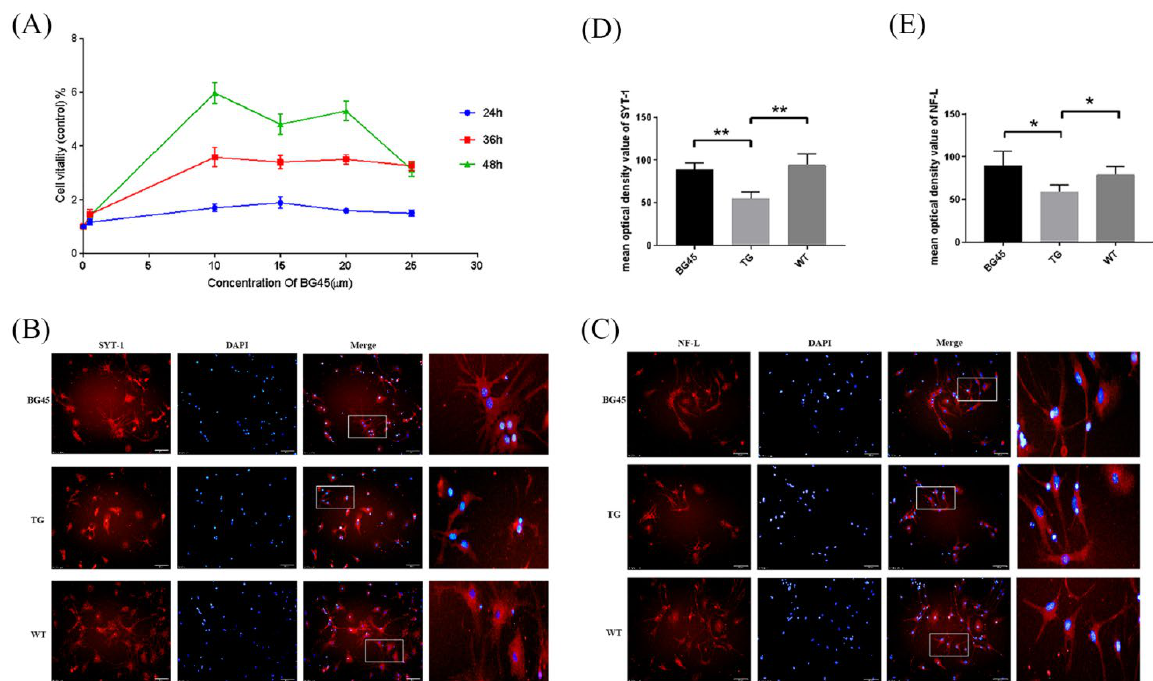
Figure 2. BG45 increased cell viability and the expression of SYT-1 and NF-L. ( A ) The viability of cells treated with BG45 (0.5, 10, 15, and 25 µ M) for 24, 36, and 48 h. ( B ) Immunofluorescence staining analysis of SYT-1 (red) in primary neurons treated with BG45 (10 µ M) for 48 h. ( C ) Immunofluorescence staining analysis of NF-L (red) in primary neurons treated with BG45 (10 µ M) for 48 h. ( D ) Quantitative SYT-1 analysis. ( E ) Quantitative NF-L analysis. The values are presented as the mean ± SD from three independent experiments. * p < 0.05 and ** p < 0.01. Scale bar = 50 μm. Immunofluorescence staining showed that compared with the WT group, the SYT-1 and NF-L protein levels were significantly decreased in the TG group ( p < 0.01, p < 0.05). Compared with the TG group, the SYT-1 and NF-L protein levels were significantly in- creased in the BG45 group ( p < 0.01, p < 0.05; Figure 2B–E). 2.3. BG45 Improved Spatial Memory and Learning Ability in APP/PS1 Mice In this study, the Morris water maze test was used to evaluate spatial memory and learning ability of mice. In the acquisition trial, the learning curve showed that the time to reach the platform (escape latency) in the BG45 group was less than that in the TG group ( p < 0.001; Figure 3A). In the probe test, the time spent in the target quadrant and the number of hidden platform crossings were significantly increased in the BG45 group ( p < 0.05, p < 0.05) and the WT group ( p < 0.01, p < 0.01), compared with the TG group (Figure 3B,C). To exclude the influence of visual differences and the swimming ability of mice in each group, visual platform trials and swimming speed tests were carried out. The results showed that there was no significant difference between these groups (Figure 3D,E).